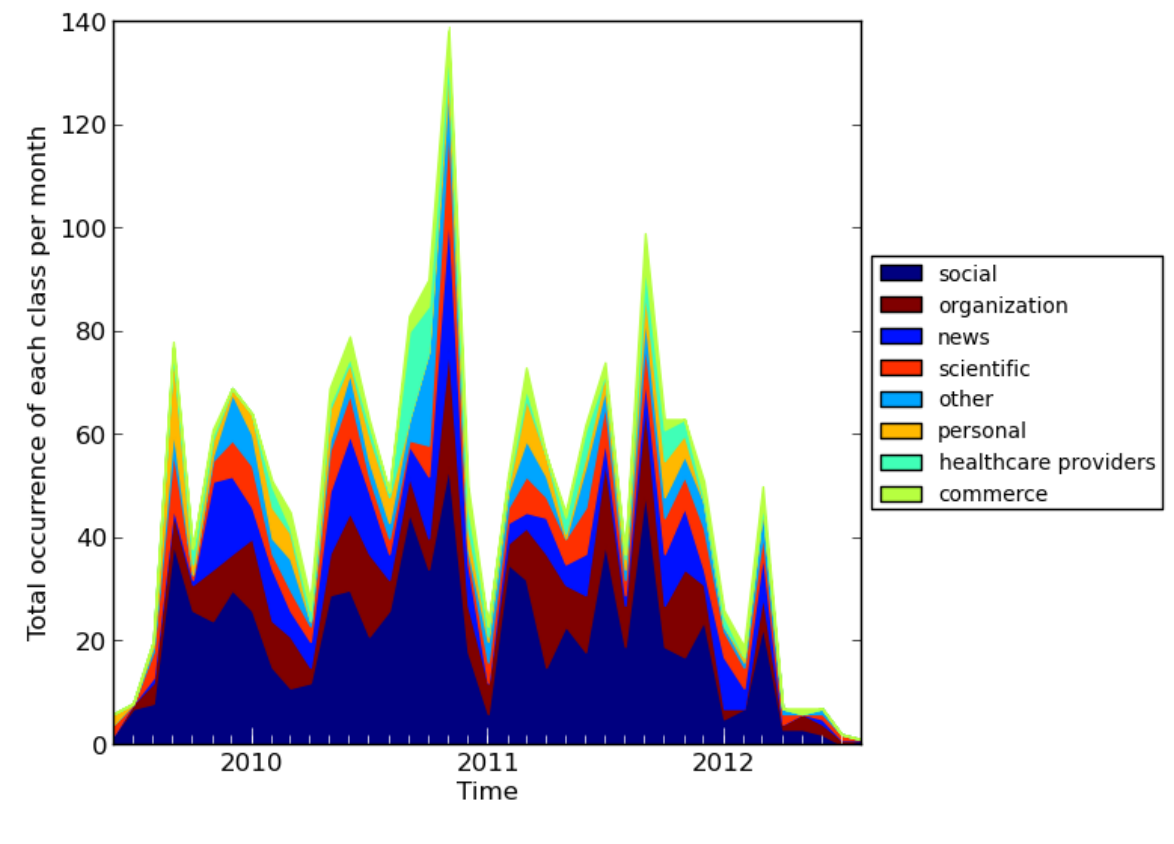
Figure 2. Timeline of posted hyperlinks for each domain